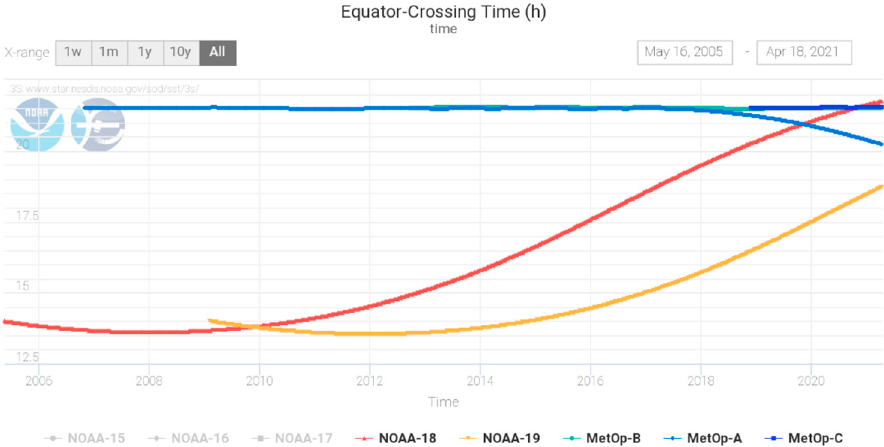
Figure 2. Local equator crossing times (LEXT) for Metop-A/B/C and NOAA-18/19. (From the NOAA Sensor Stability for SST, 3S system [37,38] which calculates the LEXTs following [36].).